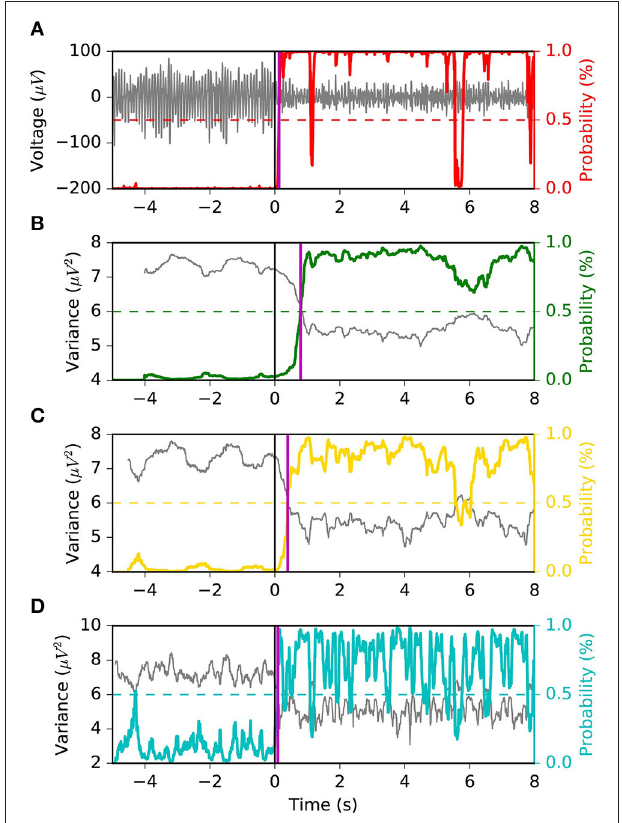
FIGURE 6 | Example 1 of the typical behavior of the four models. The same left motor imagery trial as in Figure 1 is depicted. We observe that the MSM achieves the “quickest detection”, while keeping a stable output. Panel (A) shows the EEG voltage obtained after CSP spatial filtering in gray and the MSM model output in red. Panels (B–D) represent the decoding associated with sliding window lengths 1.0, 0.5, and 0.1 s, respectively. This figure follows the same convention as in Figure 1 .